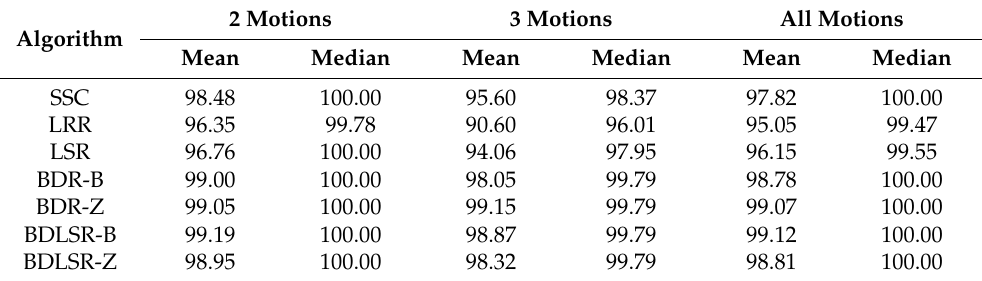
Table 2. The accuracy (%) when using the Hopkins 155 dataset with 2F-dimensional data.